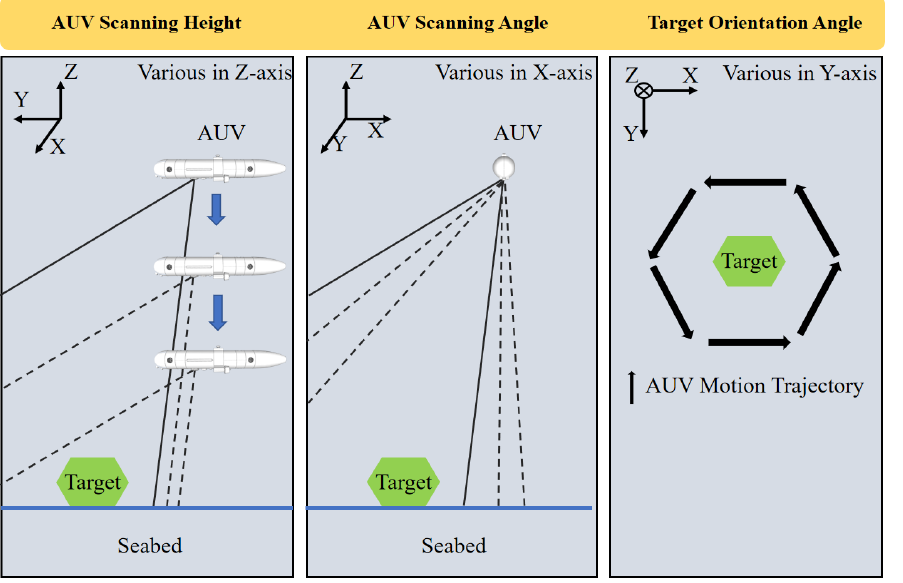
Figure 6. Illustration of the experimental scheme. The experiment collects SSS images under various conditions including various scanning heights, scanning angles, and orientation